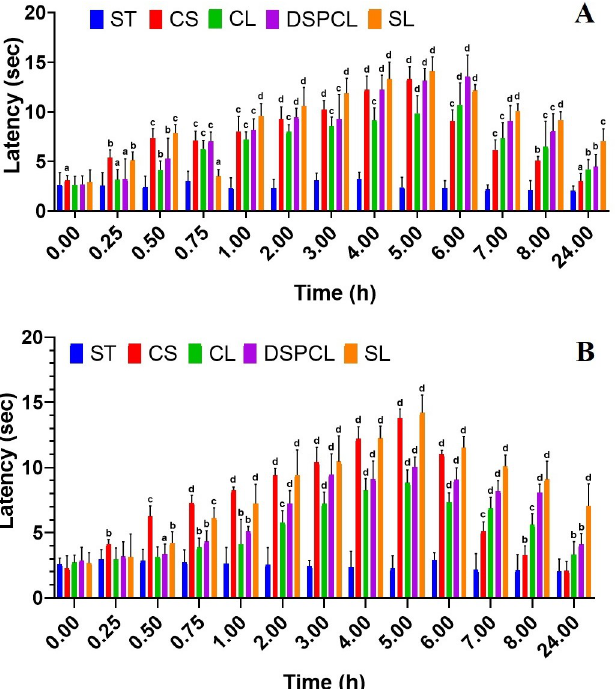
Fig 9. Analgesic activity outcomes of free CLB solution (CS), CLB conventional liposome (CL), CLB DSPC liposomes (DSPCL) and CLB stealth liposomes (SL) compared to saline treated control (ST) using (A) tail flick test and (B) hot plate test (Data expressed as mean ± SD, n = 6; a- p < 0.05, b- p < 0.01, c- p < 0.001, d- p < 0.0001).